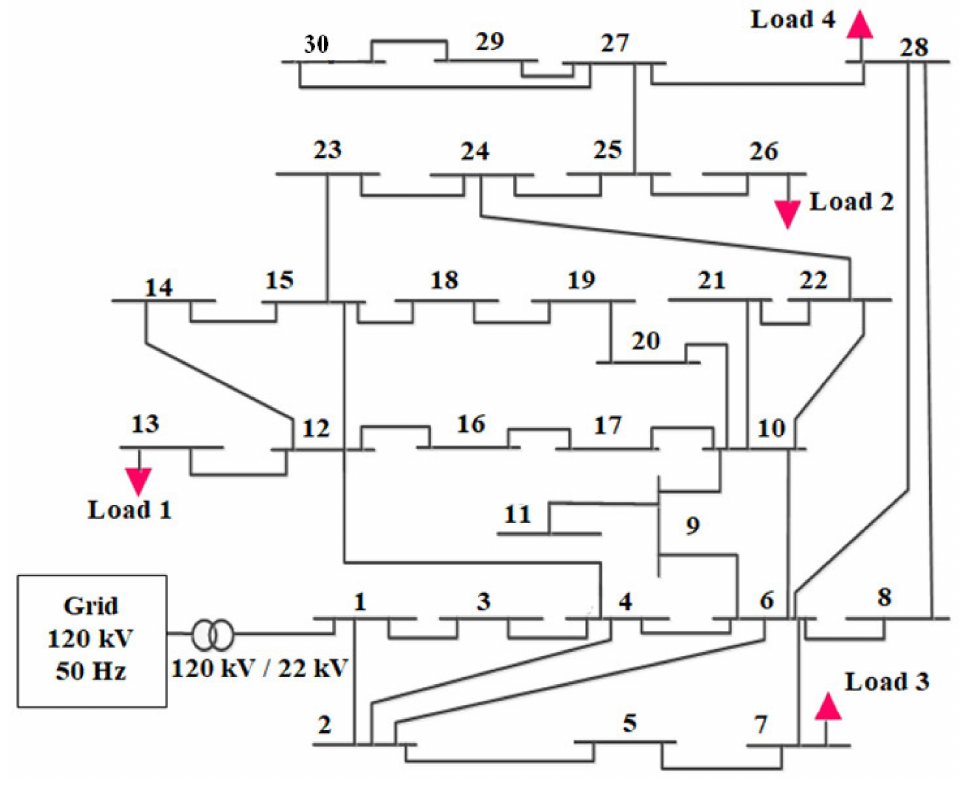
Figure 9. 30-bus test system.